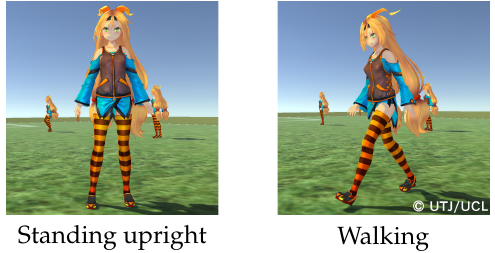
Figure 5. Example of a 3D model: Unity-chan.